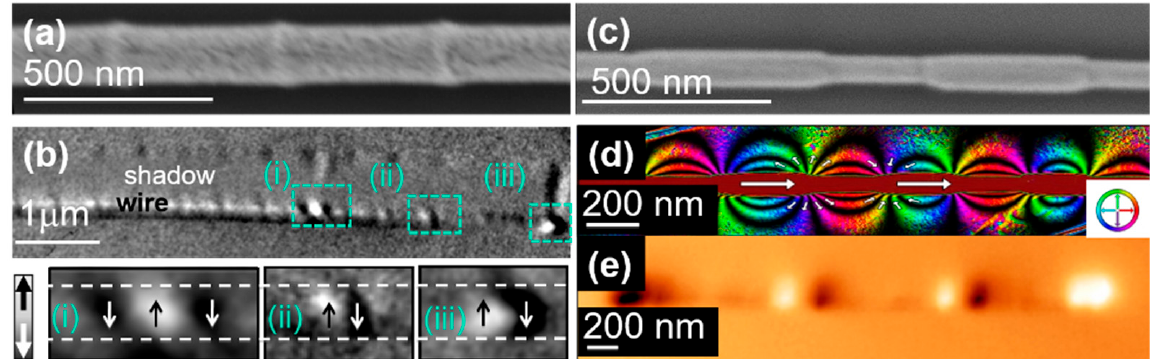
Figure 8. ( a ) SEM image of a bamboo FeCoCu nanowire, ( b ) XMCD-PEEM image of bamboo-type FeCoCu nanowire ( a ) oriented perpendicular to the incident X-rays (Adapted with permission from ref. [21]. Copyright 2016 Royal Society of Chemistry). The insets show a closer view at the local magnetic configuration marked in ( b ) by green dashed squares, ( c ) SEM image of a modulated FeCoCu nanowire, ( d ) magnetic flux images of modulated FeCoCu nanowire ( c ) reconstructed from the magnetic phase shift images, ( e ) MFM image of a modulated FeCoCu nanowire. Adapted with permission from ref. [22]. Copyright 2016, American Chemical Society.